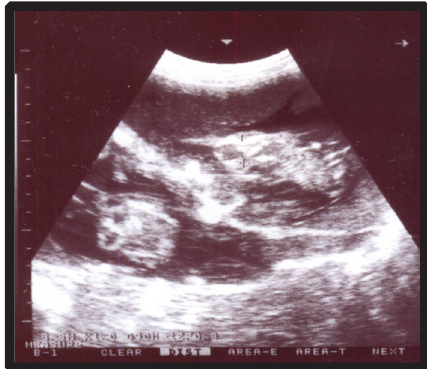
Figure 3: Hydrometra.